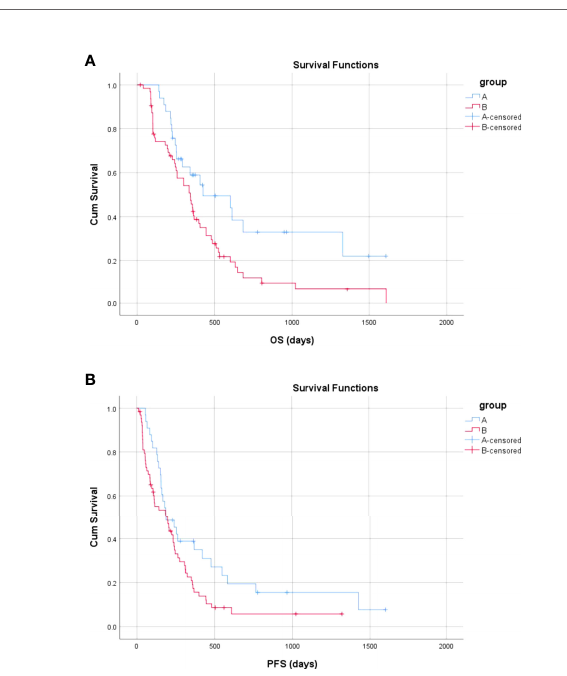
FIGURE 6 | Overall and progression-free survival in Group A (transarterial chemoembolization with portal vein embolization) and Group B (transarterial chemoembolization with molecular targeted therapy). (A) The overall survival in Group A and Group B (B) The progression-free survival in Group A and Group B.